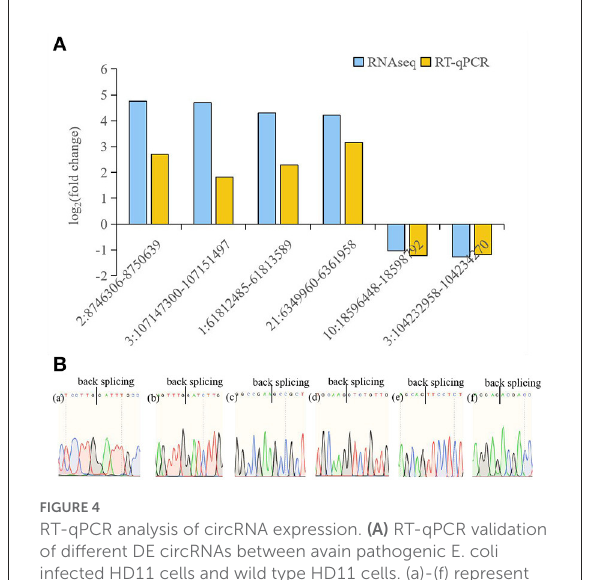
FIGURE4 RT-qPCR analysis of circRNA expression. (A) RT-qPCR validation of different DE circRNAs between avain pathogenic E. coli infected HD11 cells and wild type HD11 cells. (a)-(f) represent 2:8746306-8750639 (a), 3:107147300-107151497 (b), 1:61812485-61813589 (c), 21:6349960-6361958 (d), 10:18596448-18598792 (e), 3:104232958-104234270 (f), respectively. (B) Sanger sequencing confirmation of the back splicing junction of circRNAs.